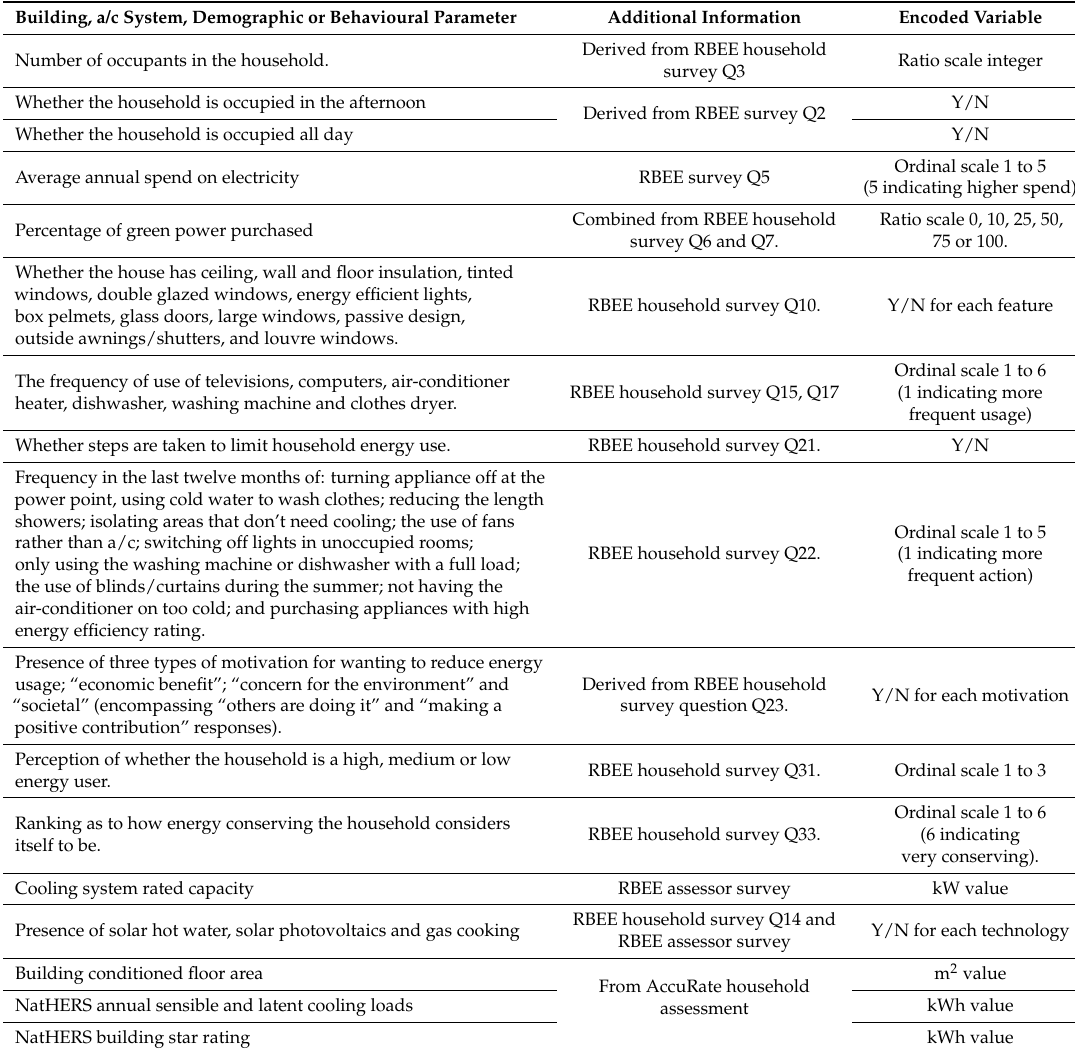
Table A2. Demographic, behavioural, building and air-conditioning system parameters used in analysis of the RBEE